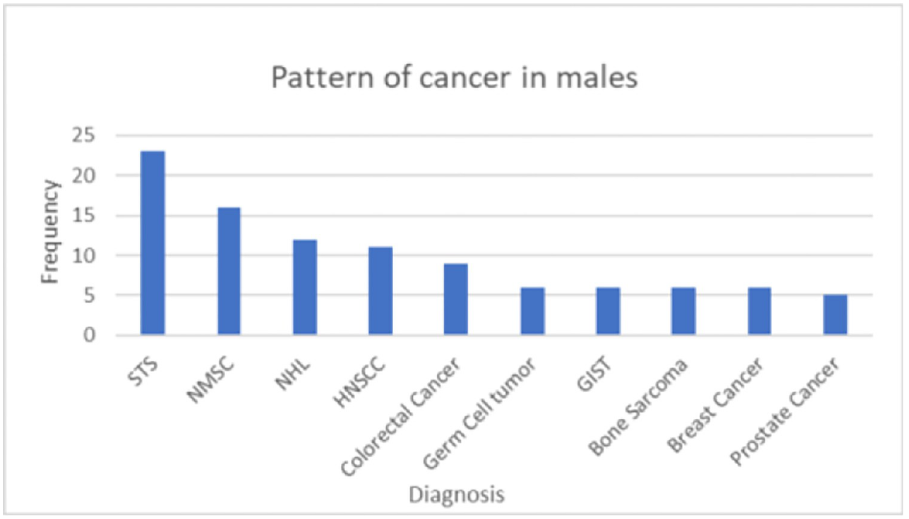
Fig 2. Cancer distribution pattern in males at Wolaita Sodo University Hospital, 2021. NMSC—Non Melanomatous Skin cancer, NHL- Non-Hodgkin lymphoma, STS—Soft tissue sarcoma. HNSCC—Head and Neck squamous cell cancer, GIST—Gastrointestinal stromal